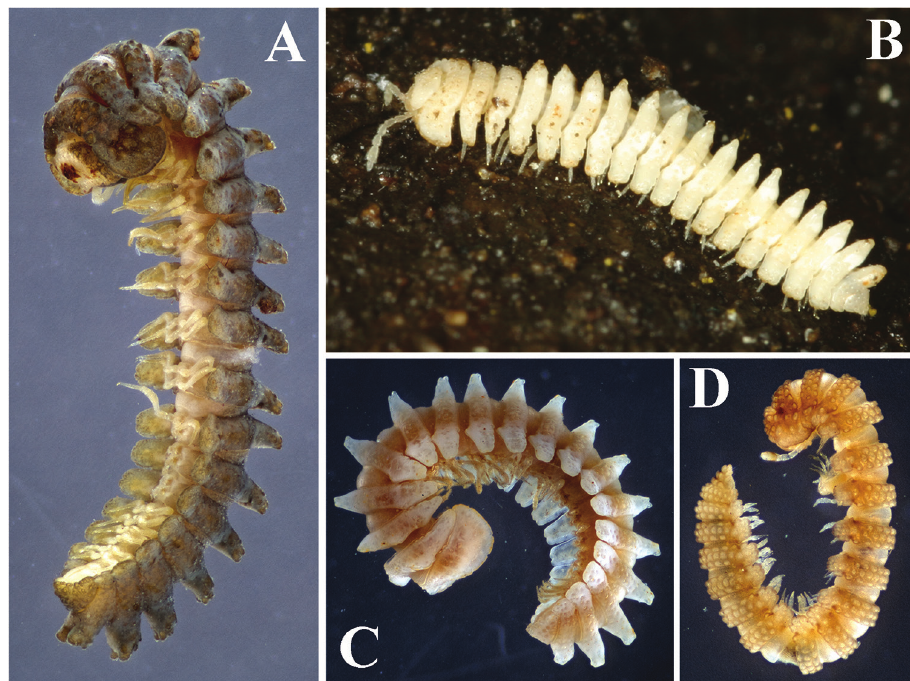
Figure 1. Habitus photographs. A E. steineri sp. n., male paratype (SMF) from Cave Tham Dout, vent- rolateral view B E. deporatus sp. n., a male ecological photo from Cave Tham Pathok, sublateral view C E. paraster sp. n., male holotype (SMF) from Cave Tham Long Puang, lateral view D E. parvus sp. n., male paratype (ZFMK) from Cave Tham Nam Long, lateral